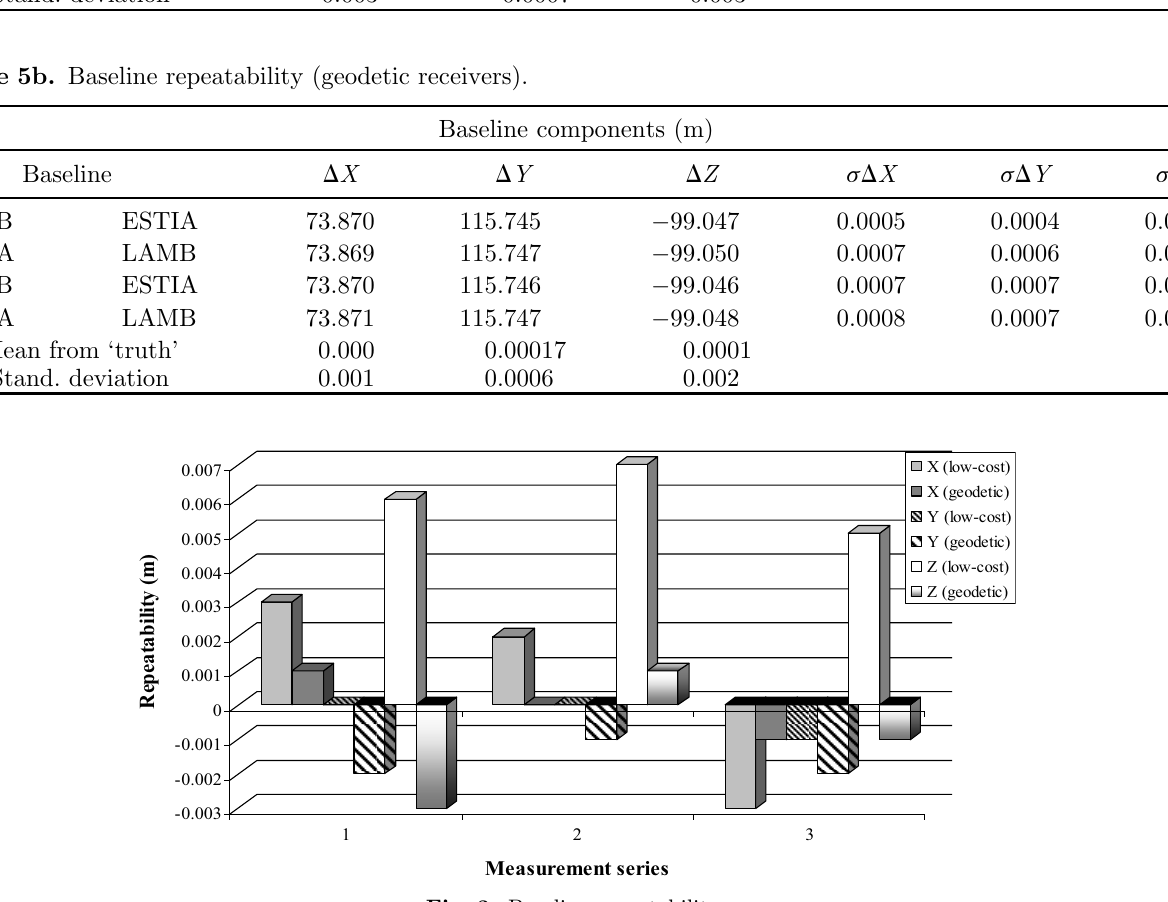
Fig. 3. Baseline repeatability.